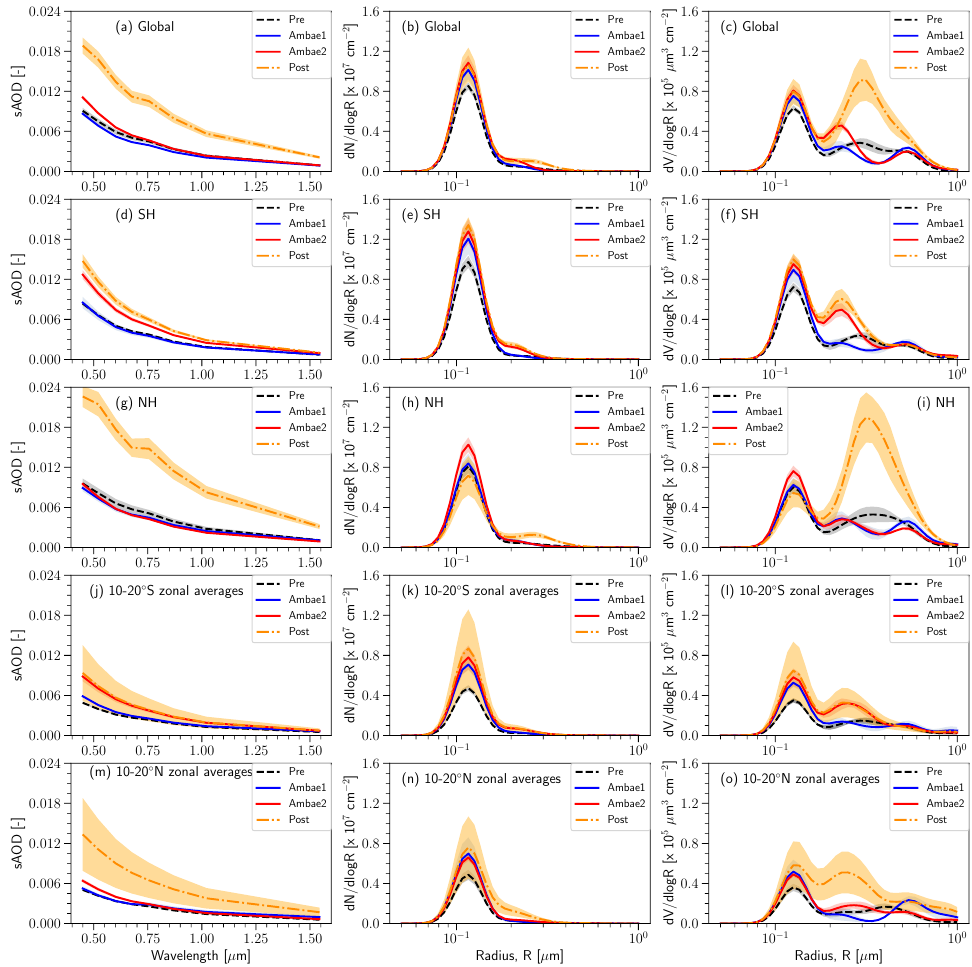
Figure 2. Spectral variation of mean stratospheric AOD (sAOD) values ( a , d , g , j , m ) and their corre- sponding number ( b , e , h , k , n ) and volume ( c , f , i , l , o ) size distributions as a function of radius derived during different periods (pre-Ambae, Ambae1, Ambae2, and post-Ambae) for global ( a – c ), SH ( d – f ), and NH ( g – i ) regions along with zonal averages in the latitudinal belts covering 10–20 ◦ S ( j – l ) and 10–20 ◦ N ( m – o ). The background fill area corresponded to the respective that the number of parameters (N i ) is fixed as 8, and the sAOD values correspond to 8 wavelengths, namely, 449, 521, 602, 756, 869, 1021, and 1544